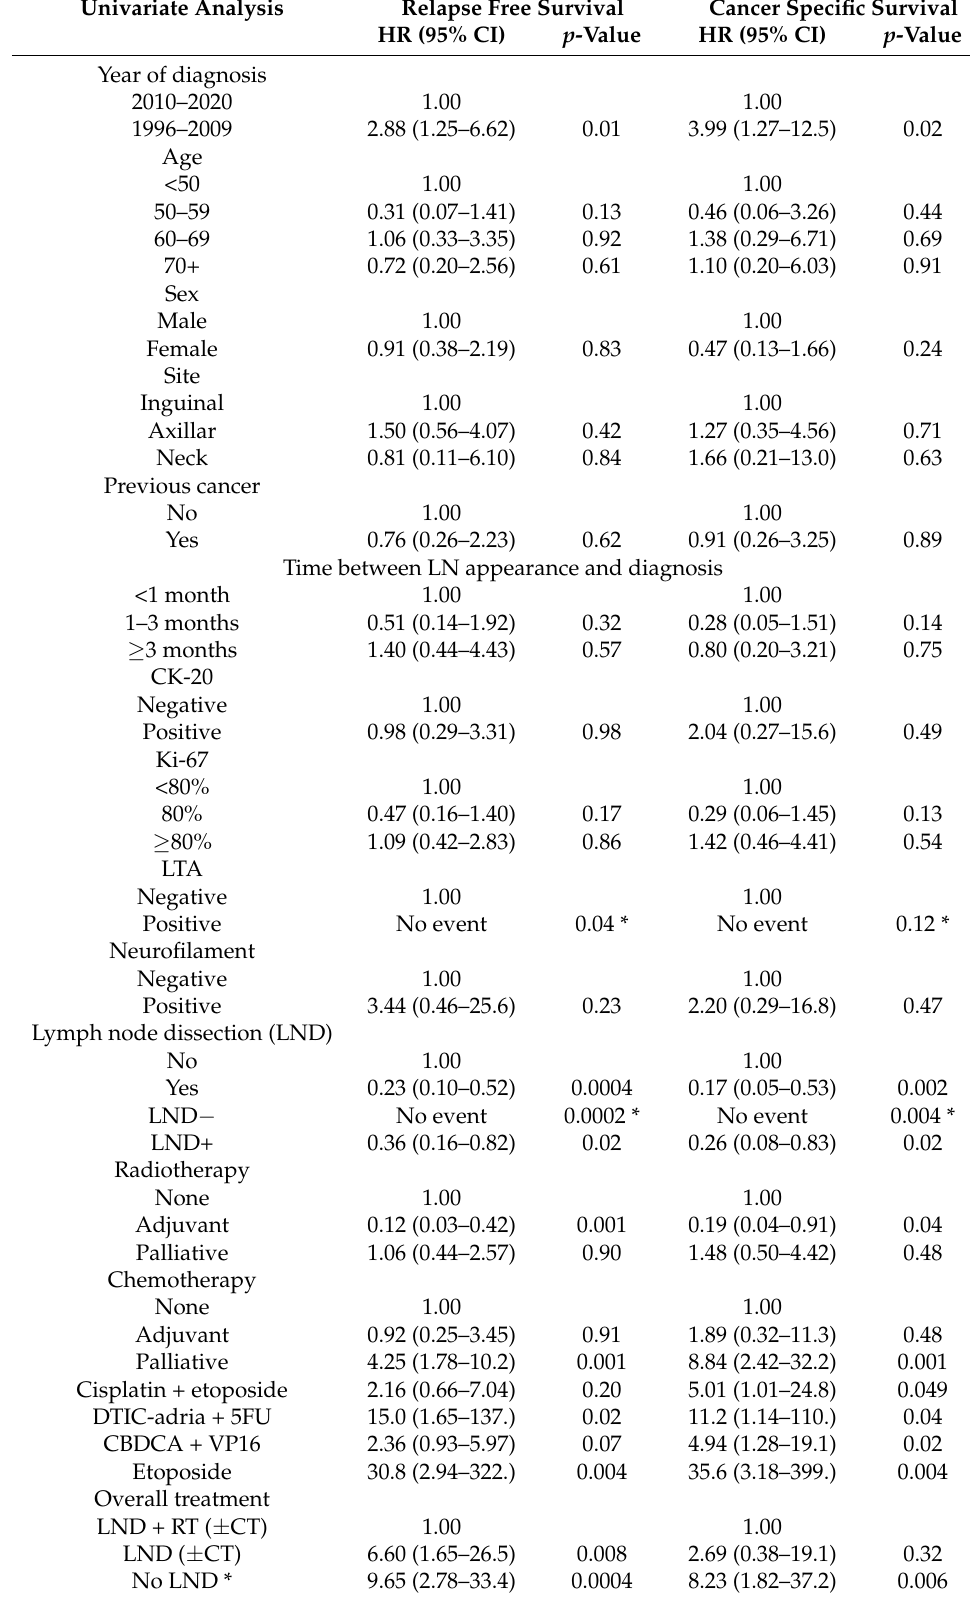
Table 3. Univariate